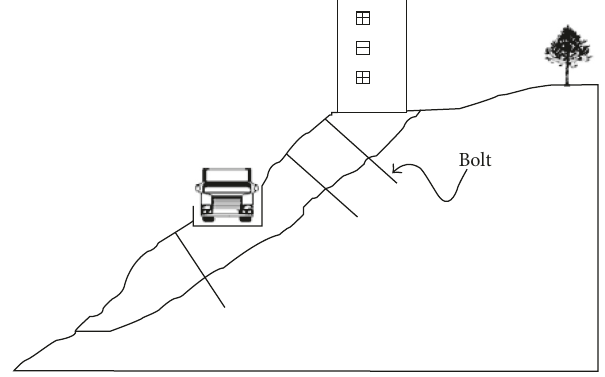
Figure 1: Bolts used in slope stability-controlling